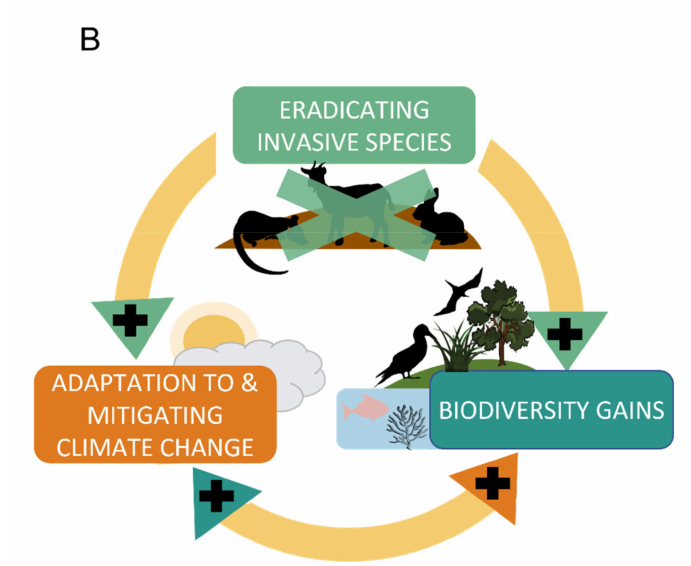
Figure 1. Conceptual summary of the major links among climate change, invasive alien species, and native biodiversity. Arrows indicate direction of influence. Arrowheads are color-coded to match the driver of influence. Symbols in arrowheads indicate if the relationship between influencer positively (+) or negatively (–) influences recipient box. ( A ) Illustrates the synergies between climate change, IAS, and native biodiversity loss and how they form a positive feedback cycle. Climate change intensifies the effects of invasive alien species (IAS), for example by increasing the risk of spread and establishment, increasing population sizes, and/or altering their diet or behavior; while also directly impacting native biodiversity via creating mismatches in species niche requirements, sea-level rise, and extreme weather events. IAS intensify and reduce the resilience of ecosystems to climate change by reducing native biodiversity, for example by increasing susceptibility of native habitats to climate change impacts such as erosion and marine heat waves, and/or IAS increase atmospheric carbon by causing a loss of carbon sequestration provided by native vegetation and undisturbed soil. In turn, native biodiversity loss is driven by compounded impacts of climate change and IAS, which degrade ecosystems making them more vulnerable to both climate change and IAS. ( B ) Illustrates how eradicating IAS from islands breaks the positive feedback cycle, improving ecosystem resilience to and mitigating the impacts of climate change while protecting native biodiversity and promoting recovery. (Figure adapted from the Invasive Species Centre, available online: https://www.invasivespeciescentre.ca/invasive-species/what-is-at-risk/climate-change/ (accessed on 17 July